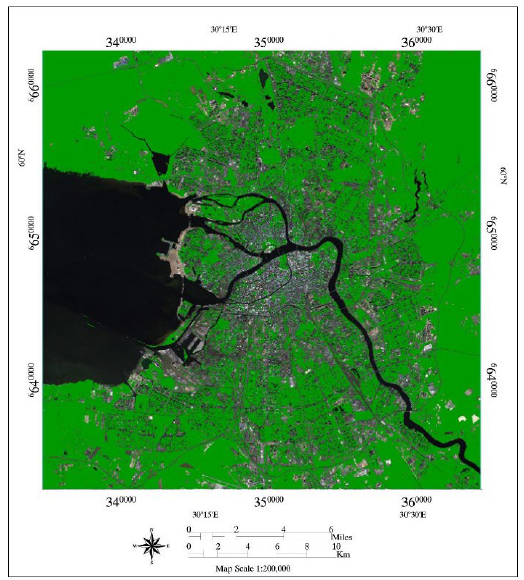
Figure 3. NDVI ROI before the mask.